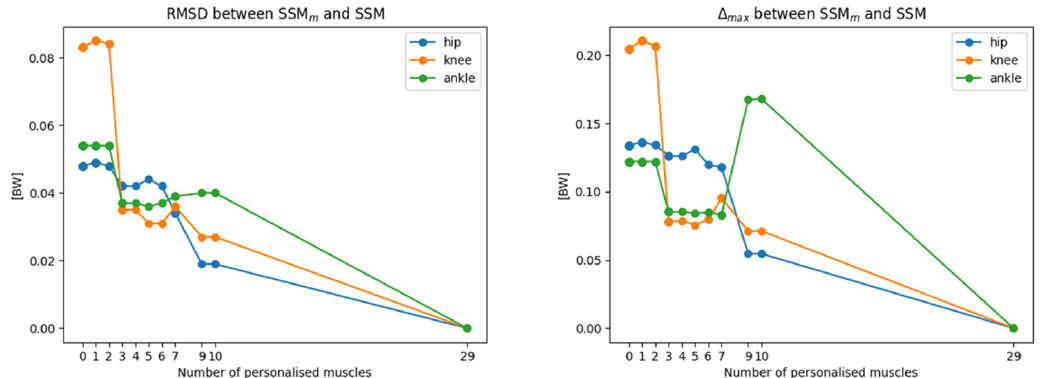
Figure 5. RMSD ( left ) and ∆ max ( right ) between fully personalised model SSM and reduced models SSM m , as a function of the number of personalised